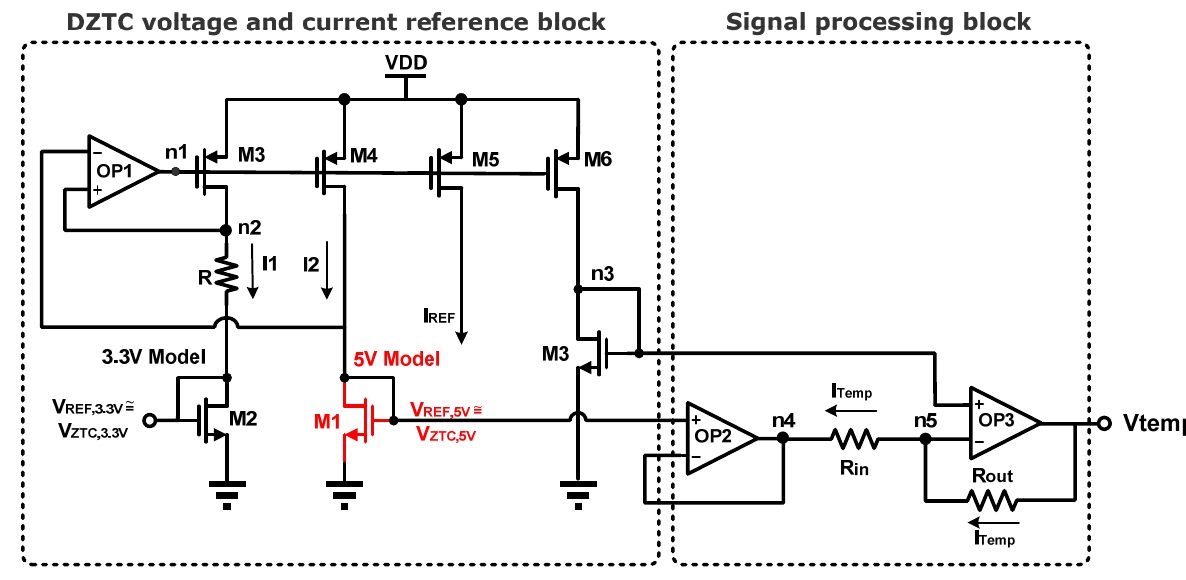
Figure 3. DZTC voltage, current reference, and temperature